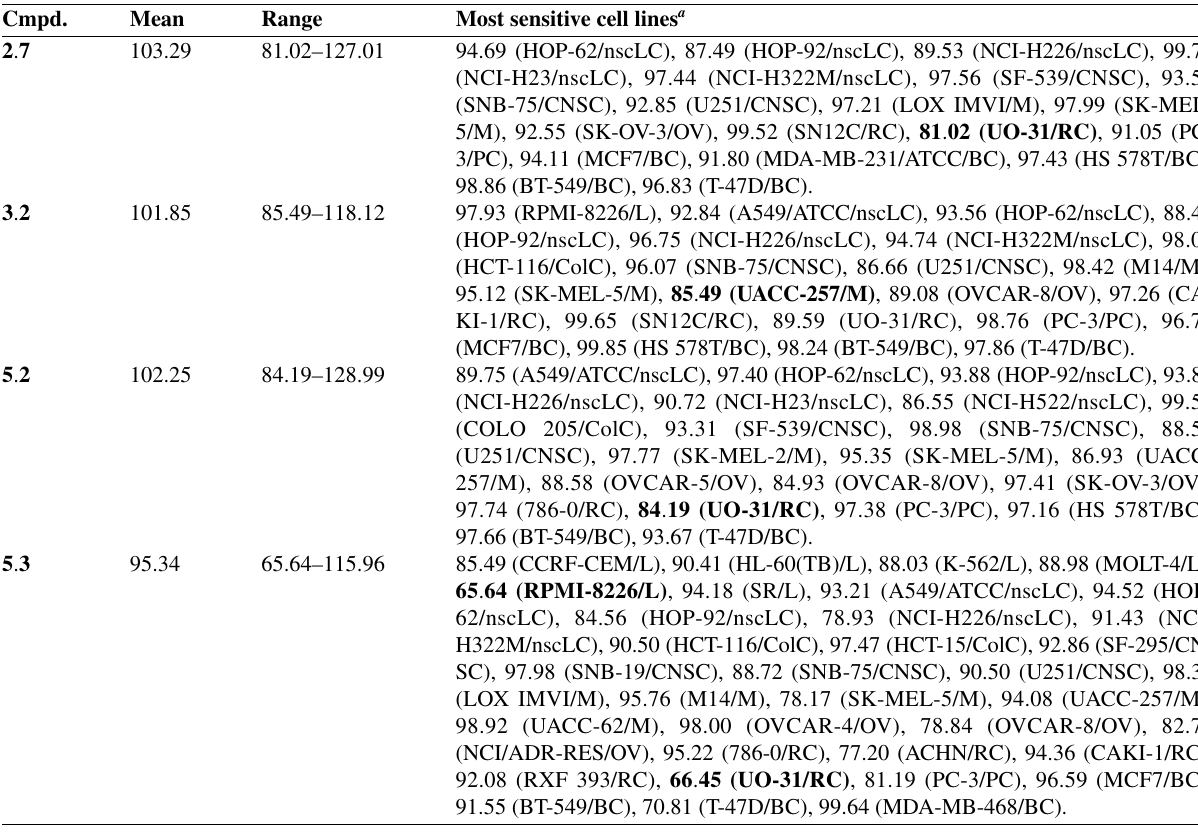
Table 1. Percentage of in vitro tumor cell lines growth at 10 μM exposed to 6- N-R -tetrazolo [ 1,5- c ] quinazolin-5(6 H )-ones (2.7, 3.2, 5.2, 5.3)